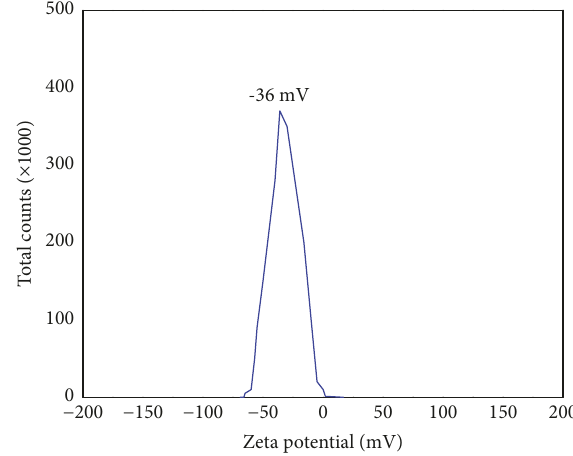
Figure 3: Zeta potential of the